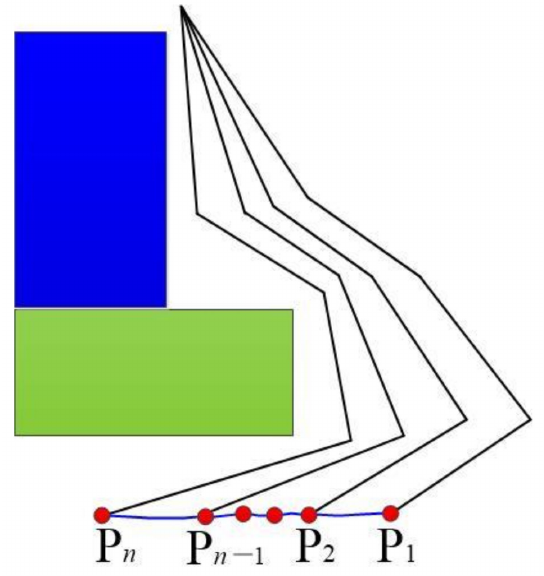
Figure 6. Via-points on the collision-free